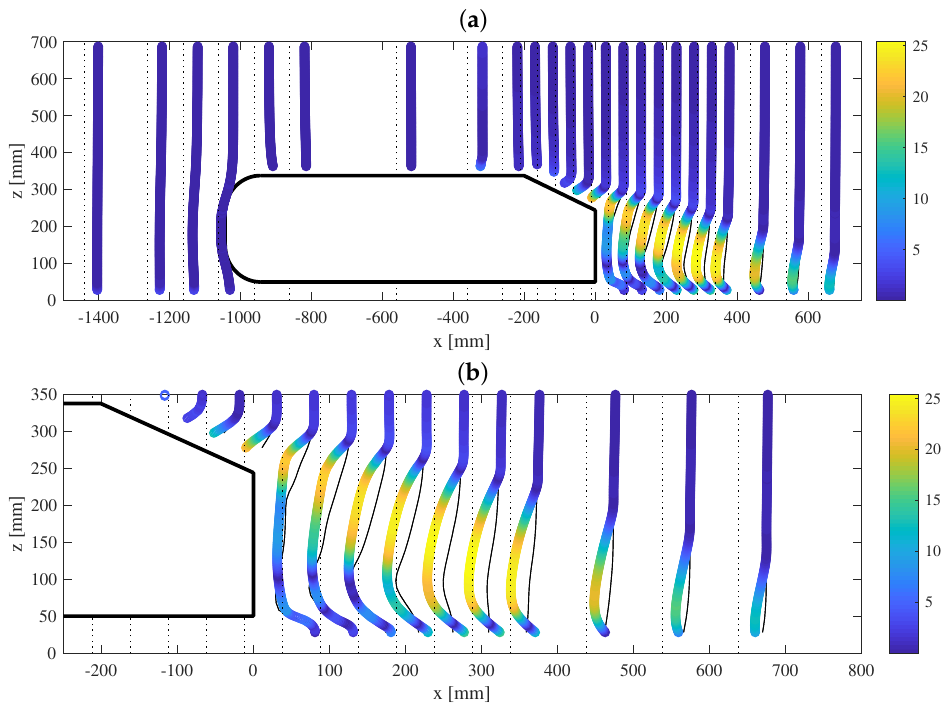
Figure 10. Velocity error for the k − ω SST turbulence model. Experimental data are presented as black lines. The unit of the colormap is meter per second (m/s). ( a ) General view; ( b ) zoom at the back of the Ahmed body.